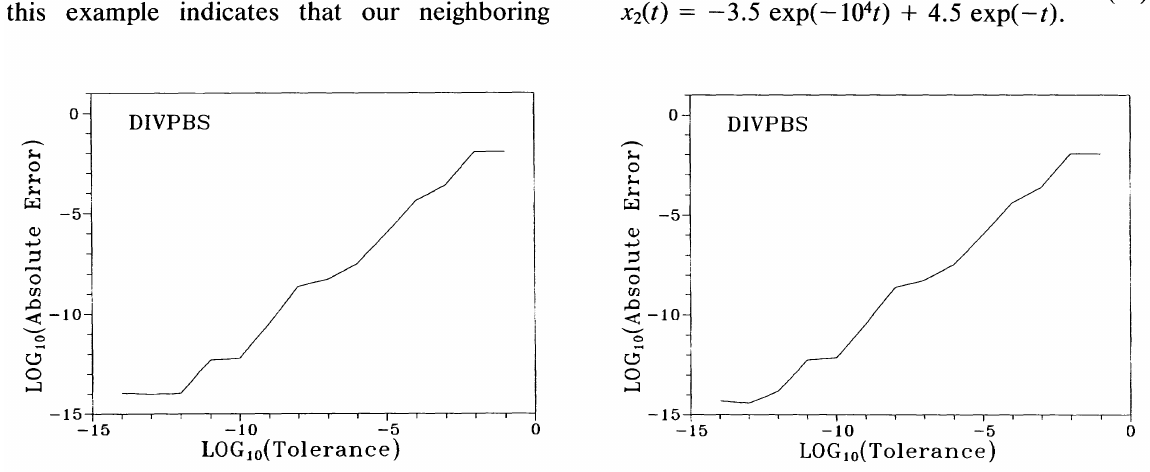
FIGURE 19 Absolute error vs. tolerance for the Euler equations